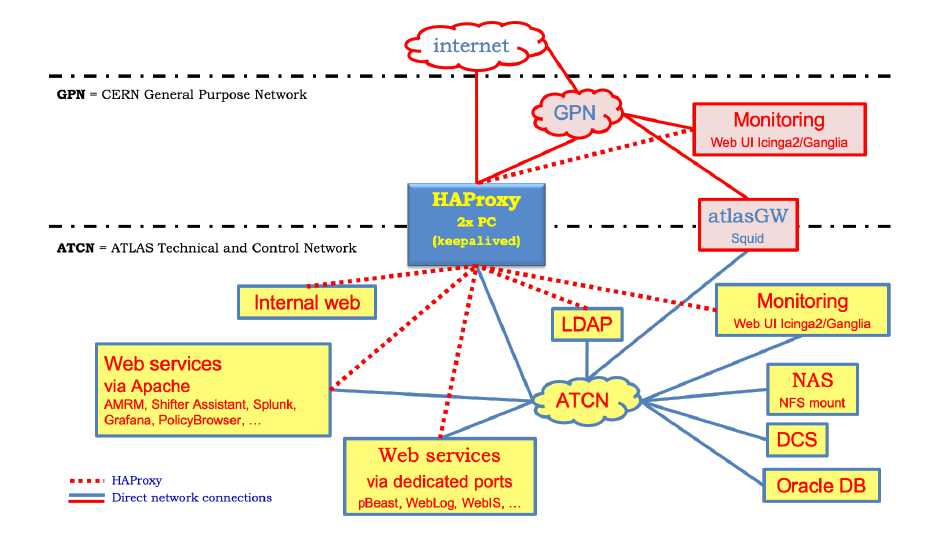
Figure 2. ATLAS new Web Service architecture based on